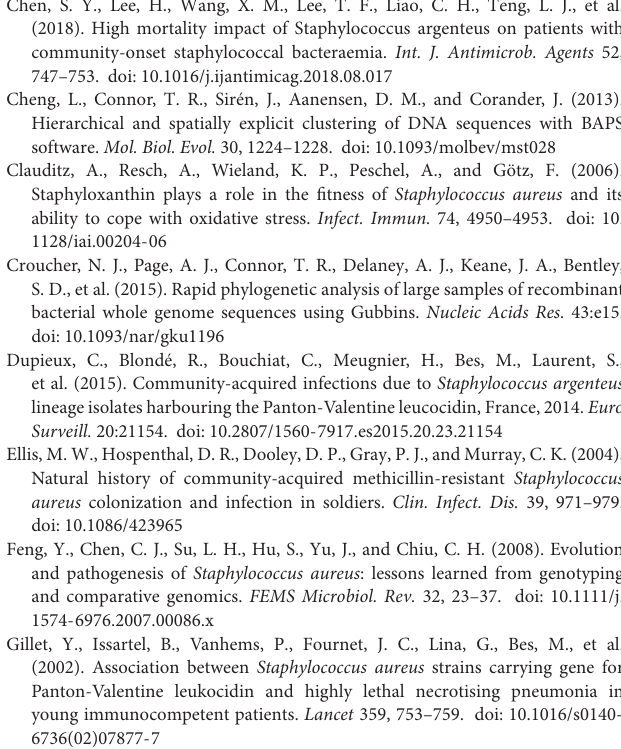
Supplementary Table 1 | Staphylococcus argenteus strains analysed in this study. Supplementary Table 2 | Gene information for the pangenome of S. argenteus . Supplementary Table 3 | Information on virulence factors in the S. argenteus pangenome. Supplementary Table 4 | Information on antibiotic resistance genes in the S. argenteus pangenome. Supplementary Table 5 | Information on region-specific genes of S. argenteus